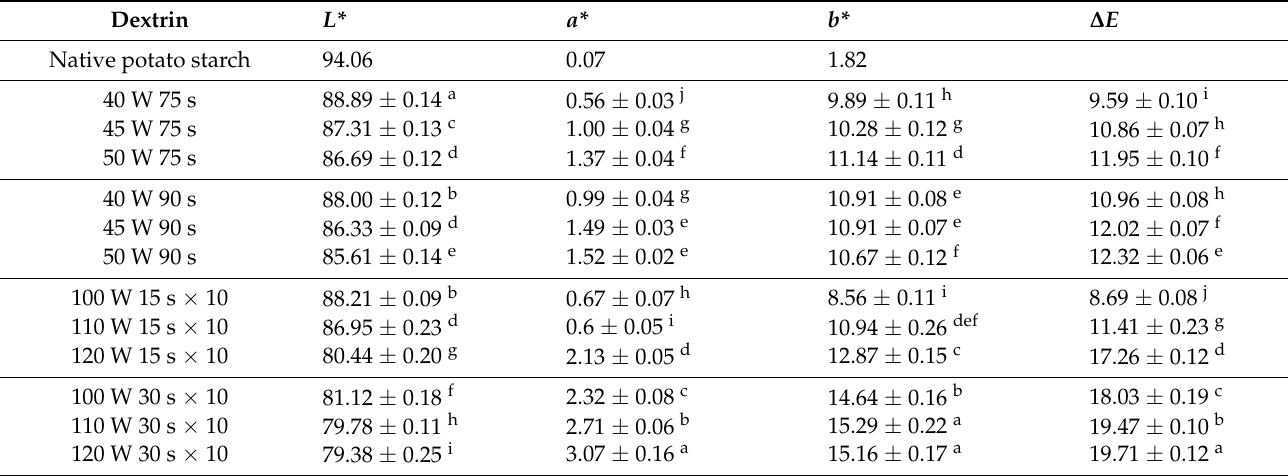
Table 1. Color parameters of dextrins obtained after exposure of potato starch to continuous and discontinuous micro- wave-assisted heating, under acidic conditions. Different superscript lowercase letters (a, b, . . . ) in the same column indicate significant differences ( p < 0.05) between each parameter for each